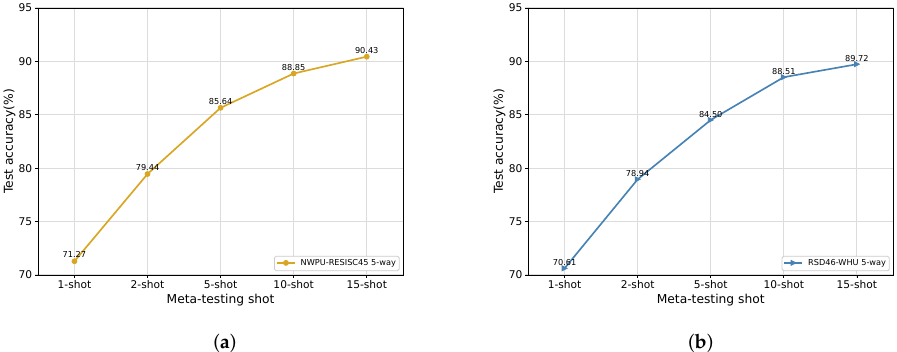
Figure 10. Ablation studies to show the performances of the meta-testing shot. ( a ) shows experimental results on NWPU-RESISC45, and ( b ) shows experimental results on